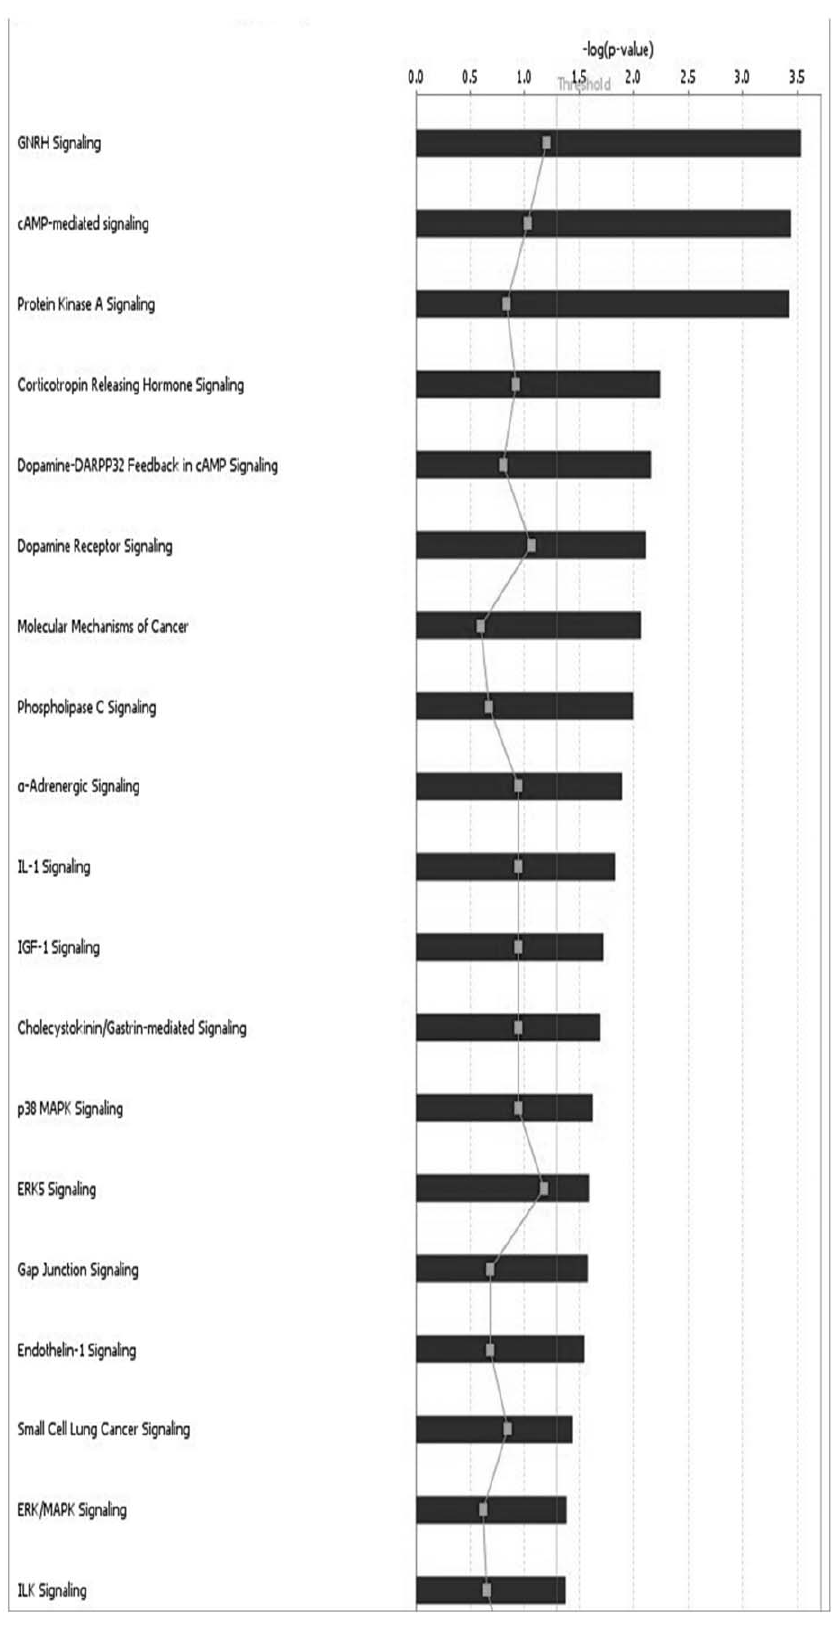
Figure 5. Cancer related Canonical pathways enriched from common genes.